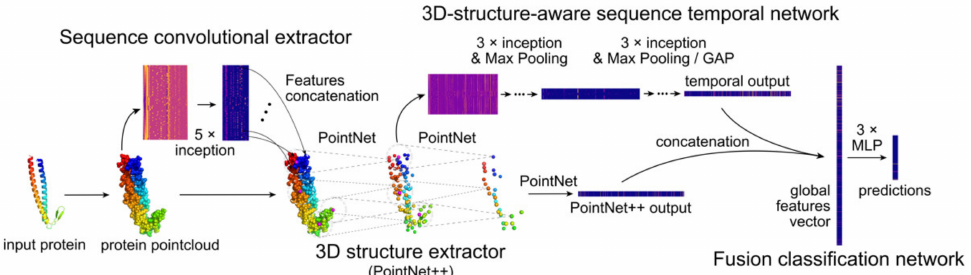
Figure 1. Summary of the BioS2Net architecture. Structural data obtained from a PDB-style file serve as a basis for generation of a protein point cloud. Sequential data is analysed by a sequence convolutional extractor with five inception modules. After features concatenation with a point cloud, merged data are interpreted by 3D structure extractor (PointNet++) in a hierarchical way by running a series of simplified PointNets. From the first set abstraction layer arises the 3D structure- aware sequence temporal network which takes as an input 512 points with raw features as well as those learnt by both extractors. It consists of six inception modules, followed by Max Pooling or Global Average Pooling. From both PointNet++ and the temporal network feature, vectors are obtained. Finally, a global feature vector is extracted and MLP is used to perform the classification. For readability, two classification heads, which introduce auxiliary losses, are omitted. Feature concatenation, which takes place while creating an input to the temporal network, is also not